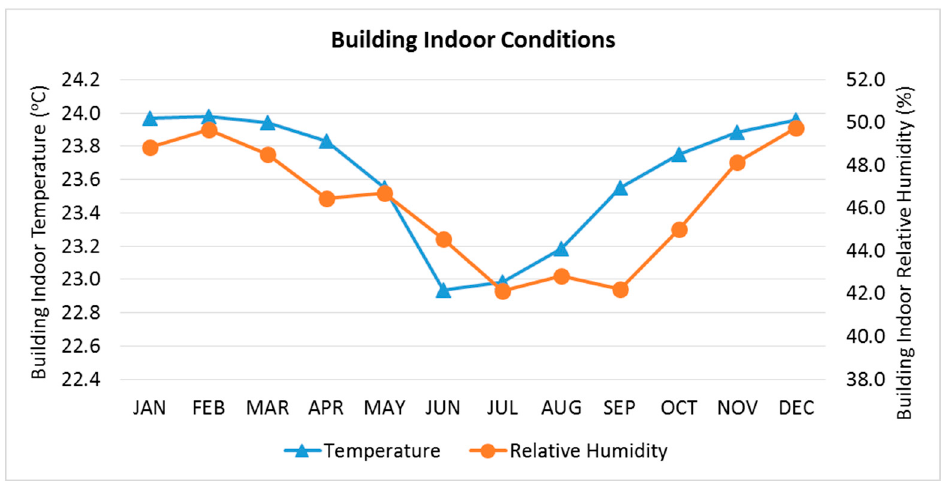
Figure 4. Monthly averaged building indoor temperature and relative humidity.